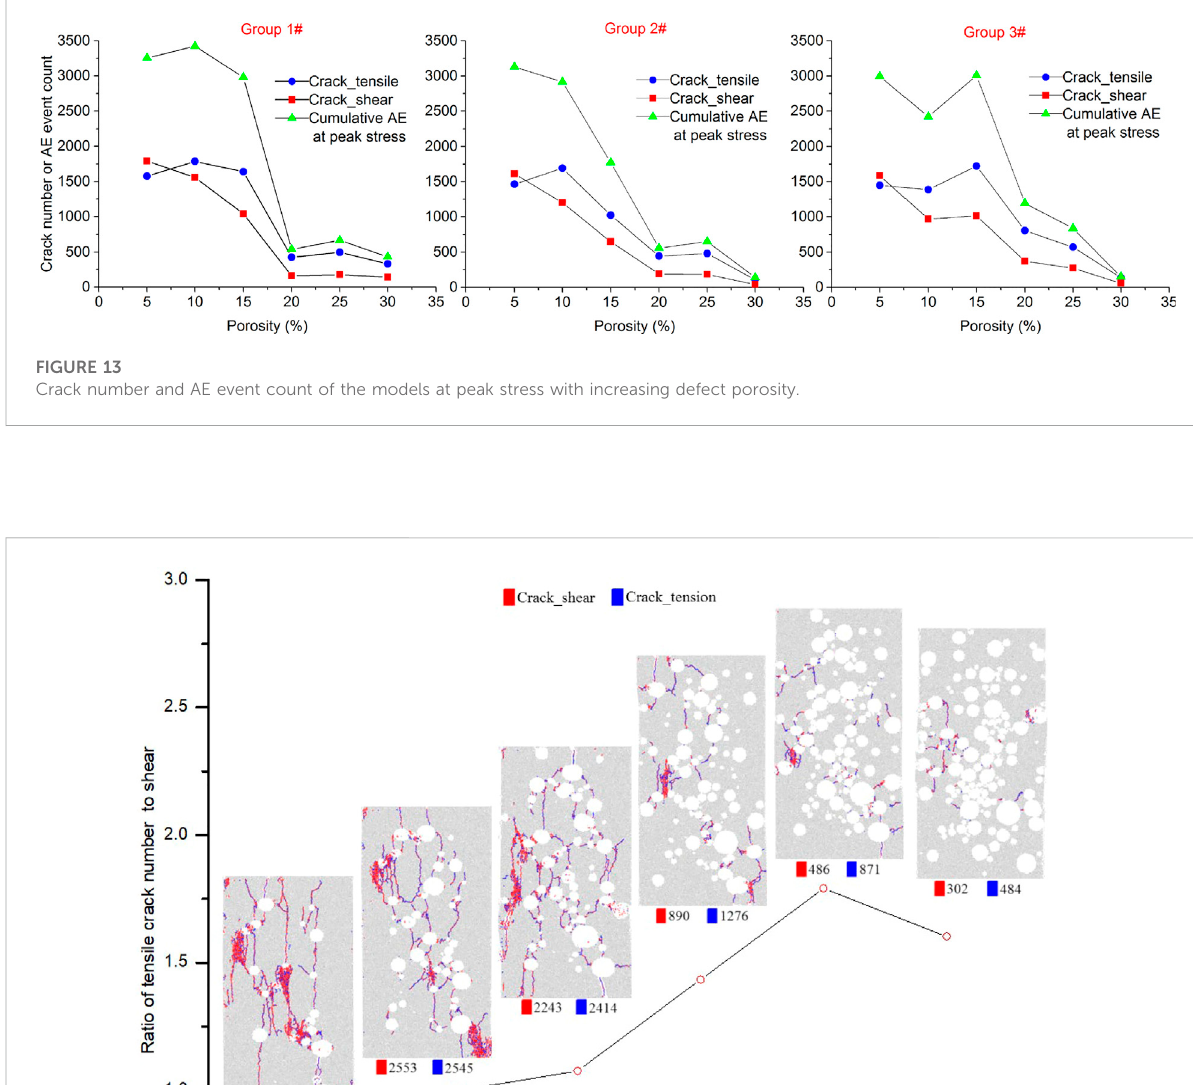
The variation curves of the crack amount and the AE intensity histograms of the numerical models containing random circular defects with increasing porosity are shown in Figure 12. The crack amount and the AE intensity both decrease with increasing porosity, but the cumulative AE events before the